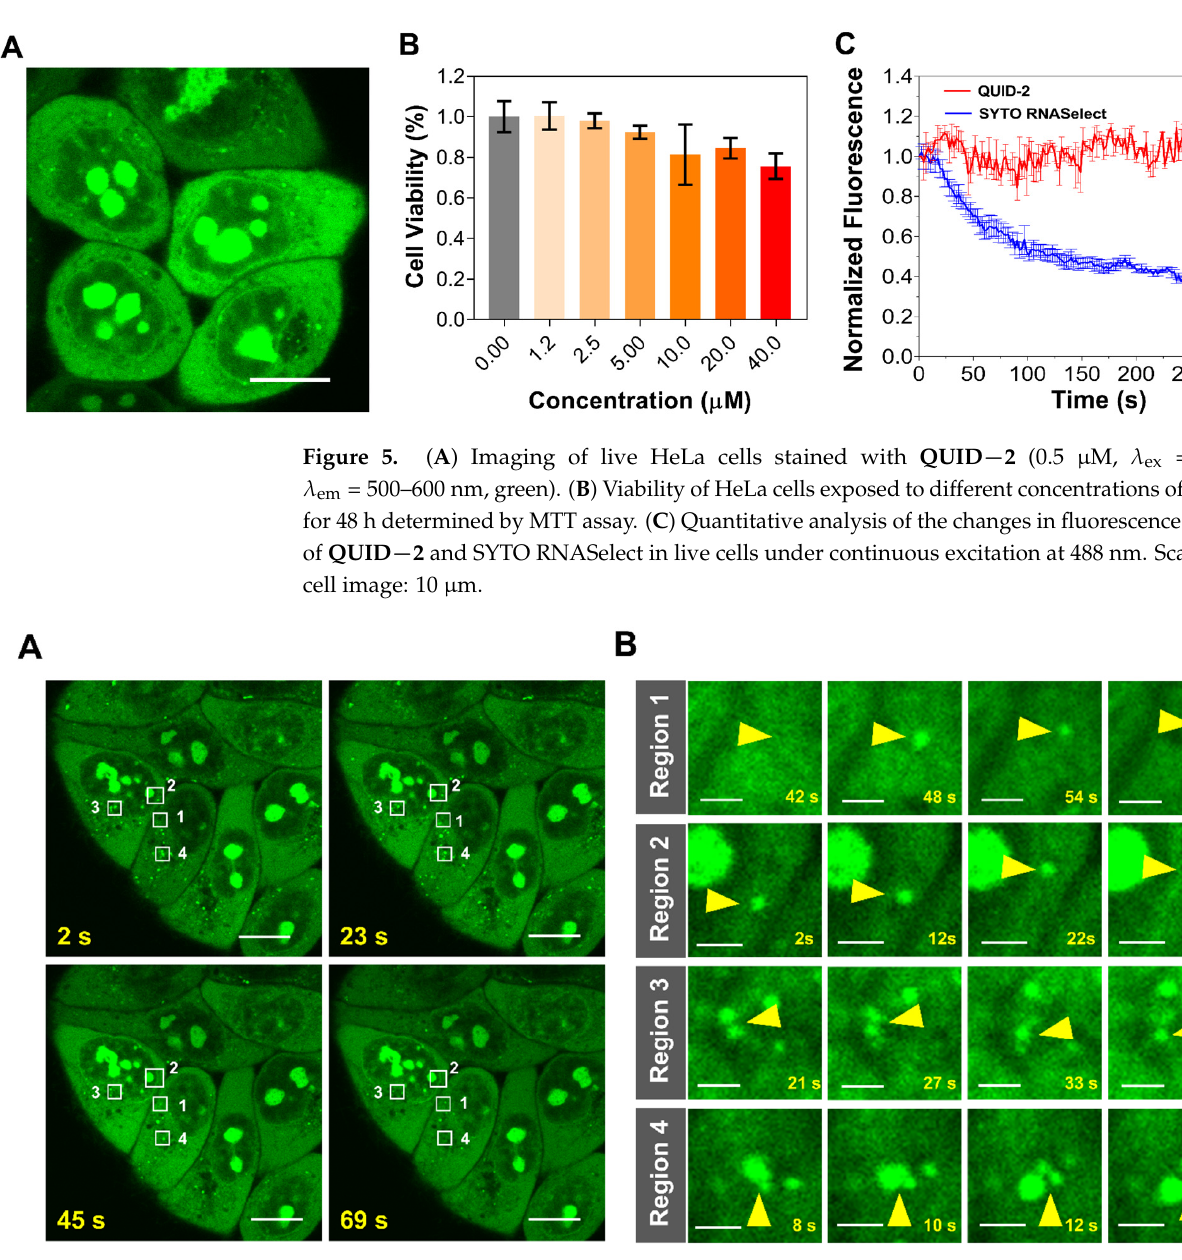
Figure 6. ( A ) Time-lapse imaging of RNA dynamics using QUID − 2 (0.5 μ M, λ ex = 488 nm, λ em = 500–600 nm, green). ( B ) Images of the region denoted by the white boxes in ( A ). Scale bars in ( A , B ) are 10 and 2 μ m, respectively.